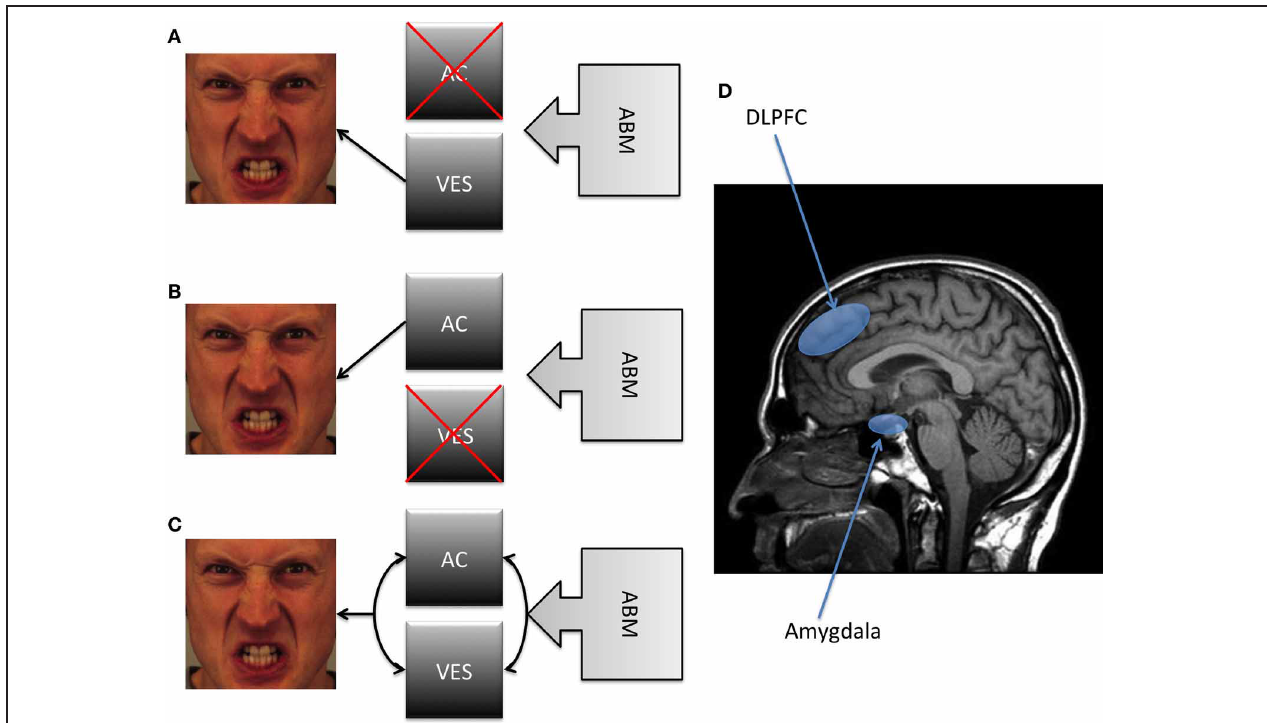
modification of the VES. (C) A third position suggests that both VES and AC are causally involved in the reduction of AB. (D) It has been suggested that the DLPFC may be considered as a proxy of AC, whereas the amygdala as a proxy of the VES. Abbreviations: AB, Attentional Bias; AC, Attention Control; DLPFC, Dorsolateral Prefrontal Cortex; VES, Valence Evaluation